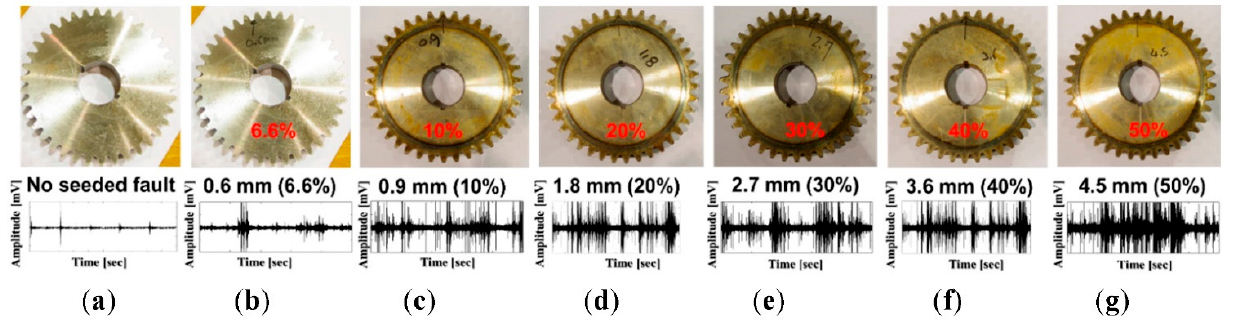
Figure 3. The multi-degree tooth cut failures of the gear wheel and the vibration signals at 600 RPM: ( a ) NF, ( b ) F1, ( c ) F2, ( d ) F3, ( e ) F4, ( f ) F5, and ( g ) Table 2. The vibration dataset for the MTCF gearbox obtained from the test rig and data acquisition equipment.